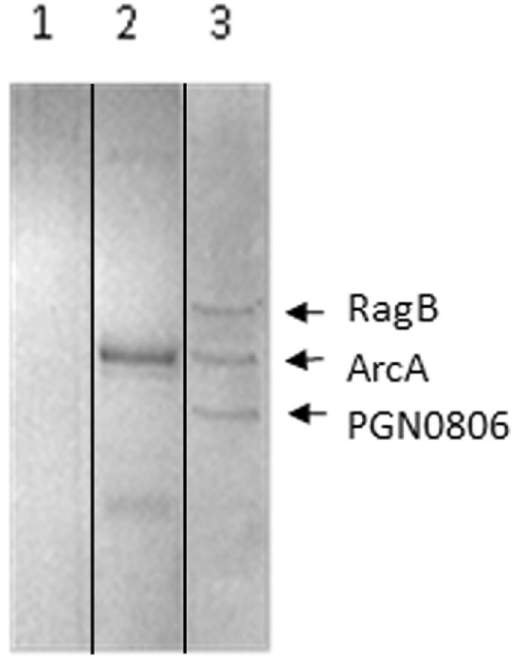
Figure 3. Interaction of ArcA and P . gingivalis surface proteins. SDS-PAGE analysis of proteins eluted from Sepharose 4B column. Lane 1, the proteins eluted from untreated Sepharose 4B column exposed to P . gingivalis 33277 extract; Lane 2, the proteins eluted from ArcA antibody-coupled Sepharose 4B column exposed to CC5A extract only; lane 3, the proteins eluted from ArcA antibody-coupled Sepharose 4B column exposed to P . gingivalis and CC5A extracts. Proteins were stained with Coomassie blue.